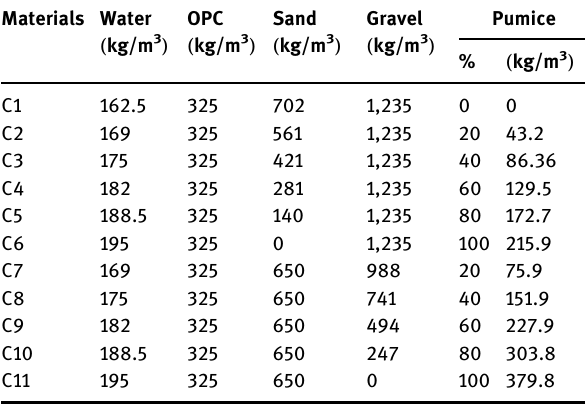
Table 6: Compositions of trail